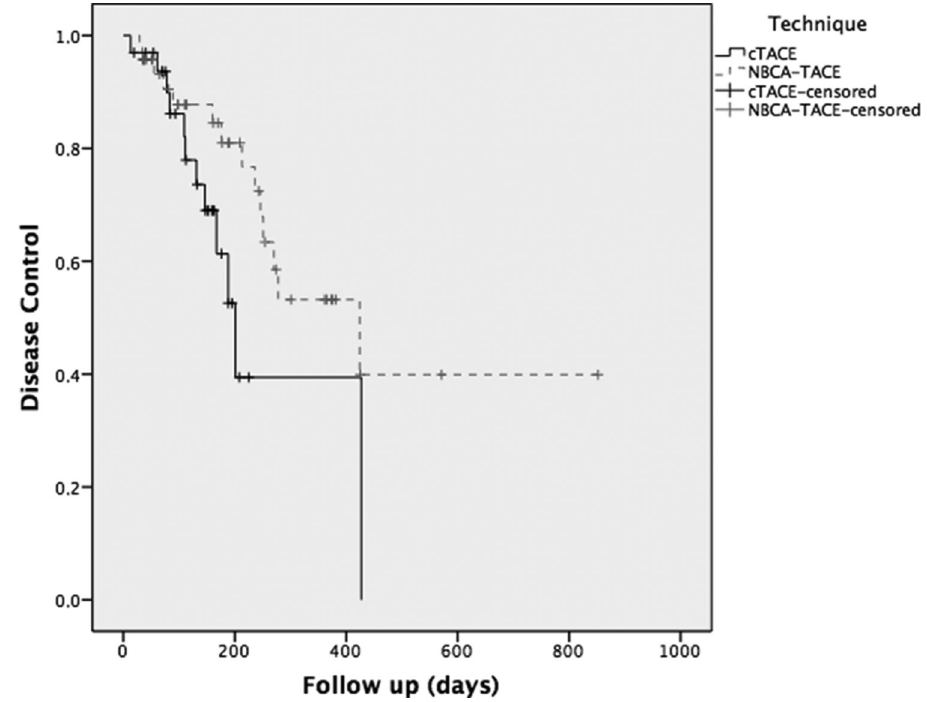
Figure 4 - Kaplan-Meier curve of TTP of patients undergoing cTACE and